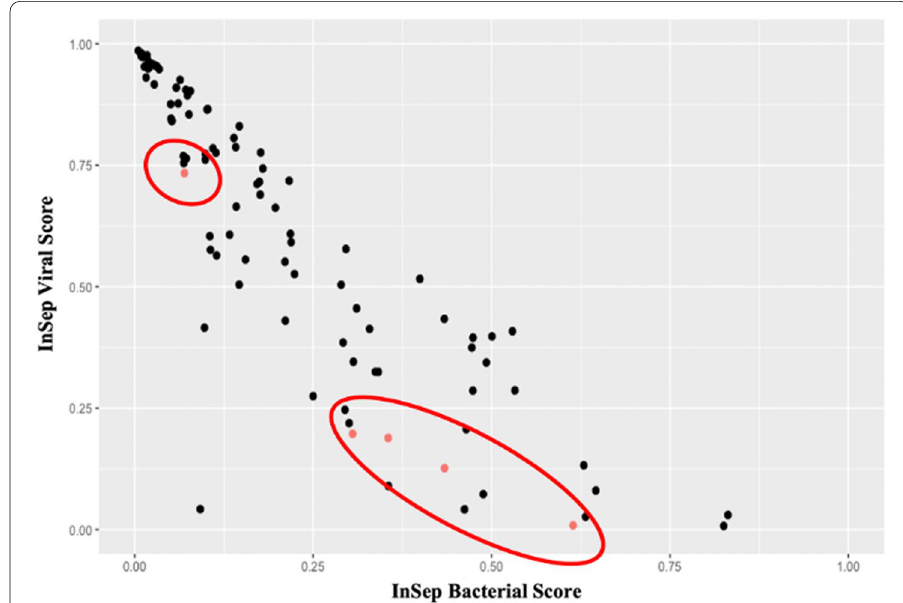
Fig. 4 InSep bacterial ( x ‑axis) and viral ( y ‑axis) scores for 97 patients with confirmed SARS‑CoV‑2 infection. Patients with microbiologically confirmed bacterial (co‑)infection are depicted in red